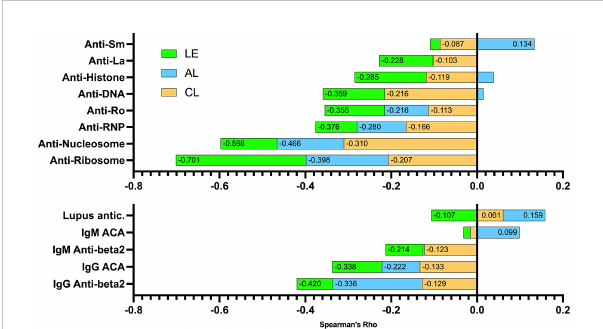
FIGURE 3 Relationship of autoantibodies to the sum of the Spearman ’ s rho correlation indices of the three C pathway functional assays. Values in the cells represent Spearman ’ s rho coef fi cients. Positive and negative correlations are shown. CL, classical (orange); AL, alternative (blue); LE, lectin (green). ACA, anticardiolipin antibodies; anti-beta2, anti- beta2glycoprotein antibodies; lupus antic.: lupus